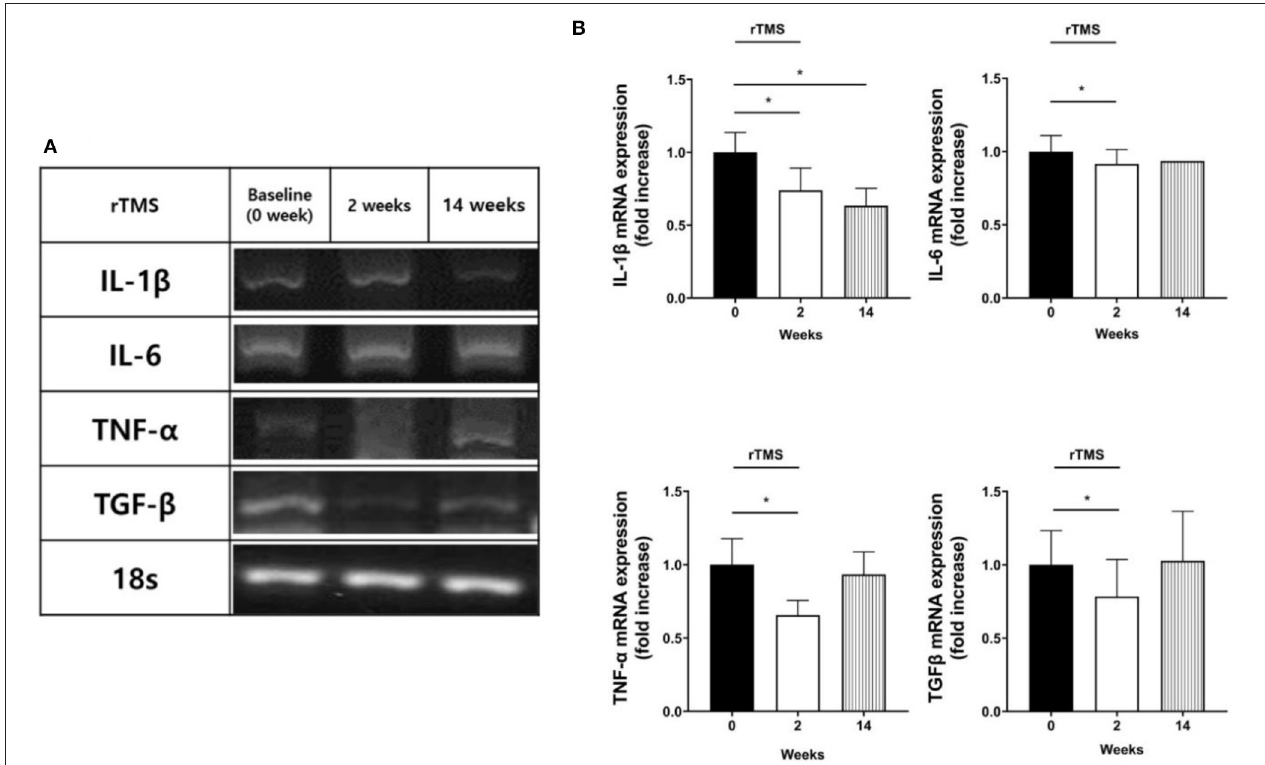
FIGURE 2 | mRNA expression results. Reverse transcription polymerase chain reaction (PCR) products of target mRNAs (IL-1 β , IL-6, TNF- α , and TGF- β ). (A) Representative agarose gel electrophoresis of PCR products on cDNA from human peripheral blood mononuclear cells. (B) The relative levels of target mRNA expression. The amount of mRNA expression was quantified by densitometry of bands in comparison to 18s. Densitometry of mRNA band was quantified by three independent scans presented as mean ± standard error (SE) of the mean for ten patients. * p < 0.05; Wilcoxon signed-rank test was used for each follow-up point compared to the baseline.